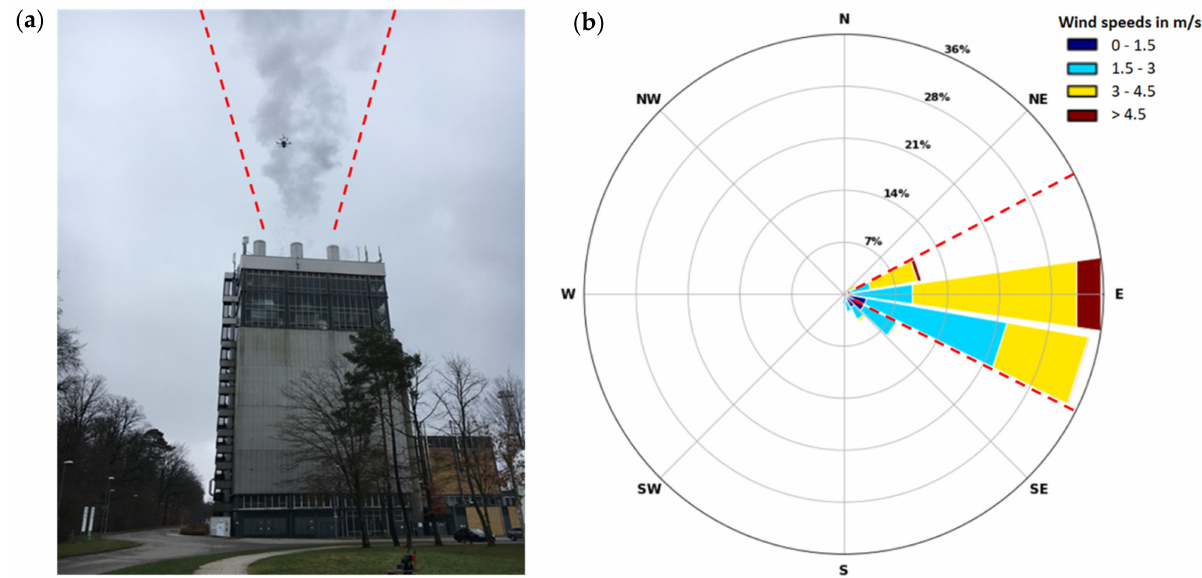
Figure 7. ( a ) Picture taken during the ascent at 12:08 local time and ( b ) wind rose showing the wind speed and wind direction measured with the TriSonica Mini during the same ascent on 31 January